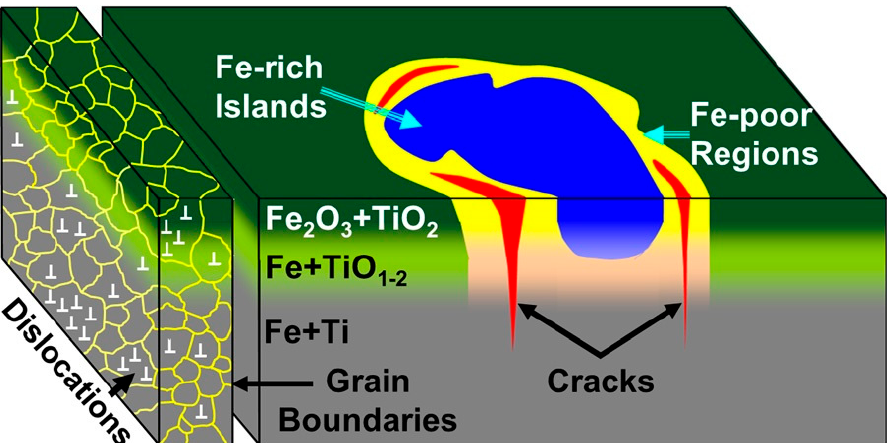
Figure 11. Schematic illustration of the most important microstructural features (i.e., cracks, grain boundaries, dislocations and Fe-rich islands) enhancing the activation of TiFe alloy [121].